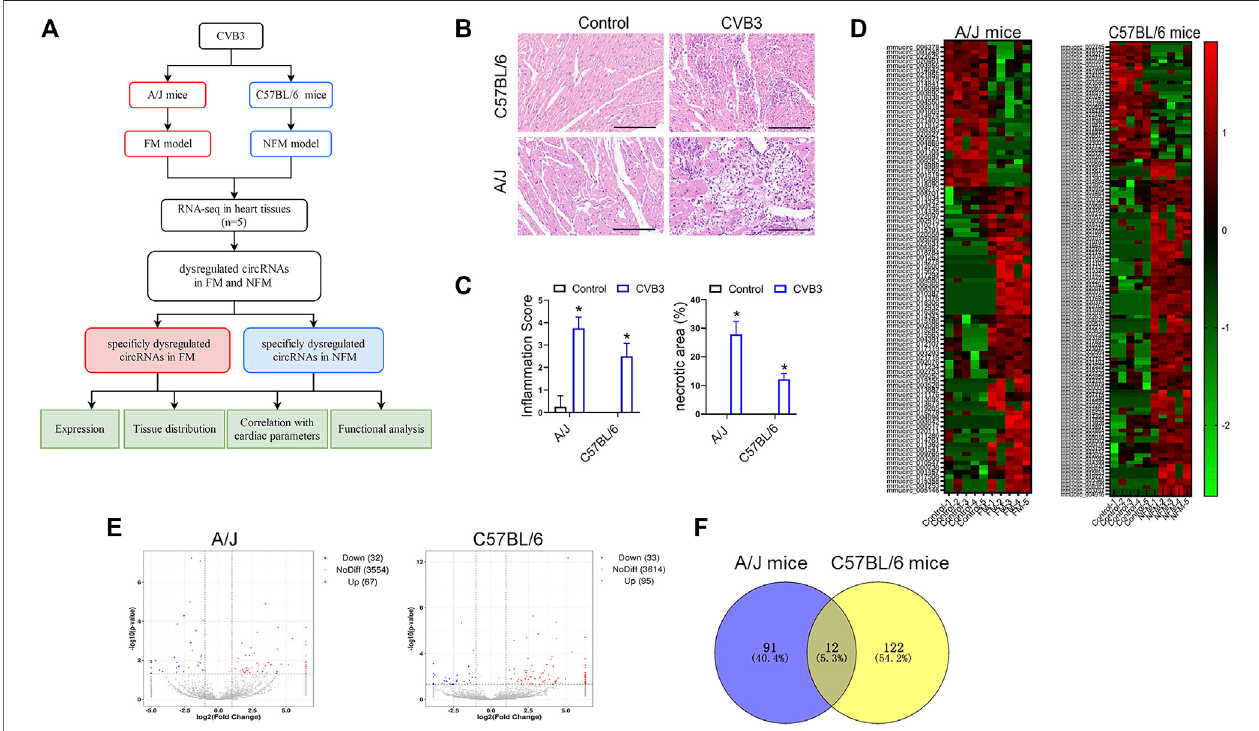
FIGURE 1 | Identi fi cation of differentially expressed circRNAs in viral FM and NFM. (A) The fl owchart of the present study. (B) Cardiac leukocyte in fi ltration and myocyte necrosis were detected by H&E staining in A/J or C57BL/6 mice respectively. (C) In fl ammation score and necrosis area were performed for evaluating the severity of myocarditis; * p < 0.05. (D) Hierarchical cluster analysis of circRNAs between CVB3 and control groups. Red strip, high relative expression; green strip, low relativeexpression;Colorbrightnessre fl ectsthedegreeofexpressionincreaseordecrease. (E) VolcanoplotoftheexpressionofcircRNAsinhearttissues.Thered or blue plots represent up- or down-regulated circRNAs with p < 0.05, whereas the black plots represent insigni fi cant changes. (F) Venn diagrams showed overlap of abnormally expressed circRNAs between A/J and C57BL/6 myocarditis models.